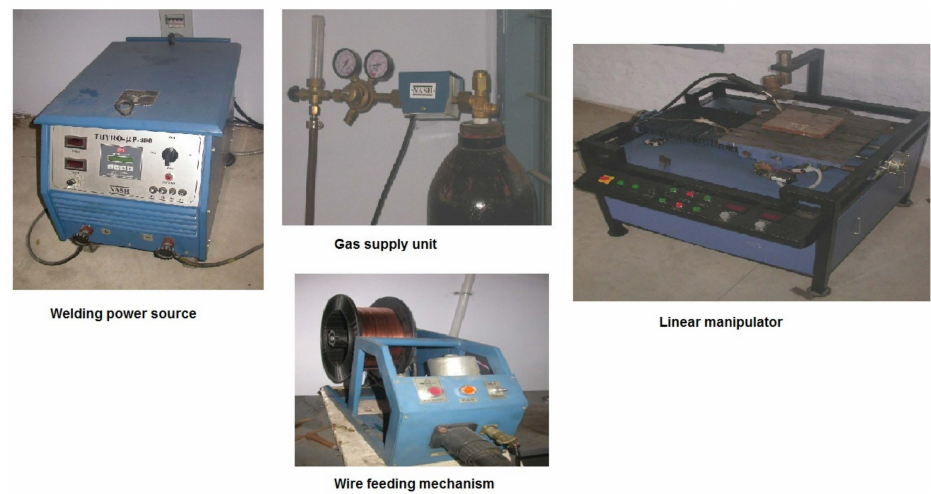
Figure 3. Experimental